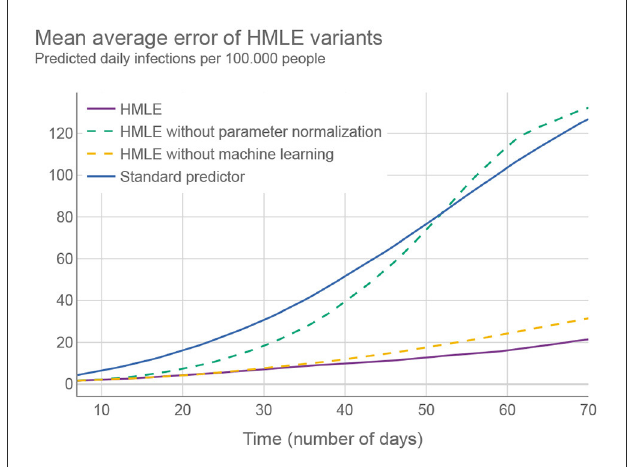
FIGURE3 Different versions of the HMLE method compared to the “standard predictor” (9). Testing was conducted on 50 random time intervals for each of the selected 194 territories.